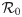
Sensitivity of β(t) estimation error to the mean 〈β〉 and amplitude α of seasonal forcing.Contained in each panel are heatmaps of median RRMSE (Eq (33)) in estimates of a seasonally forced β(t) (Eq (27)) from simulated reported incidence time series, as a bivariate function of the mean 〈β〉 and amplitude α of seasonal forcing. The 〈β〉 axis has been scaled to measure the basic reproduction number R0 (Eq (2)). When simulating reported incidence, reference values (Table 1) were assigned to all data-generating parameters except 〈β〉 and α. A grid of (R0,α) pairs with levels R0=2,3,…,32 and α = 0, 0.01, …, 0.2 was considered, with 〈β〉 defined for each value of R0 via Eq (2). For each parametrization, 1000 simulations were performed with environmental stochasticity [ES] (ϵ = 0.5) and with or without demographic stochasticity [DS] and observation error [OE], as indicated by row: [Row A] without DS or OE (prep = 1, trep = 0 weeks), [Row B] with DS but without OE (prep = 1, trep = 0 weeks), [Row C] with DS and OE (prep = 0.25, trep = 2 weeks). Corresponding mock birth and natural mortality time series were created, then β(t) was estimated from the data using [Left] the S method and [Right] the SI method, all without input error. For each set of estimates of β(t) (1000 estimates per parametrization, per simulation method, per estimation method), the median RRMSE was calculated (after smoothing with fixed q; see Eq (59)) and displayed as one point in the appropriate heatmap, coloured according to the logarithmic scale on the right. The darkest blue indicates median RRMSE less than 0.01.